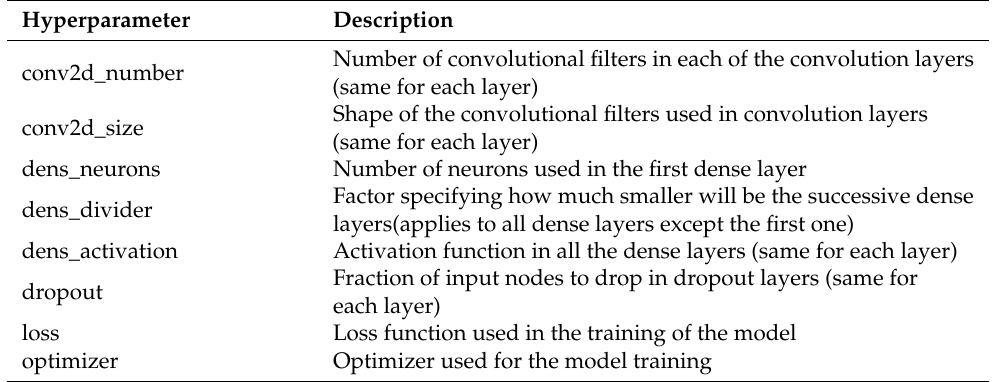
Table 2. Hyperparameters of the optimized